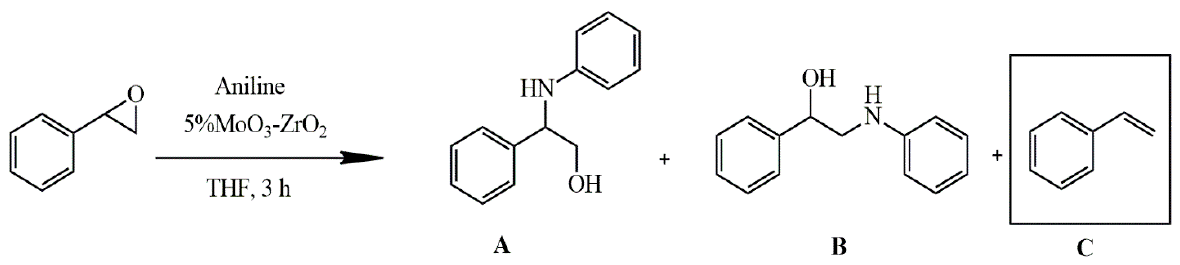
Scheme 2. Reaction of styrene oxide with aniline in the presence of THF, possibly producing styrene resulting from ygenation process. deoxygenation